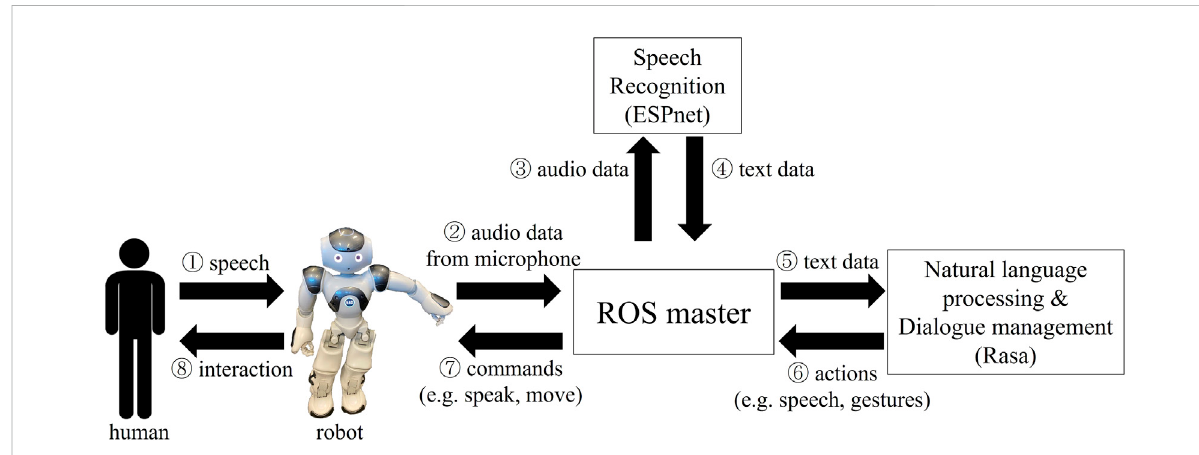
FIGURE 1 The data fl ow in the proposed dialogue interaction system that integrates ROS, ESPnet, Rasa, and Nao robots. Modi fi ed from Fujii and Jokinen